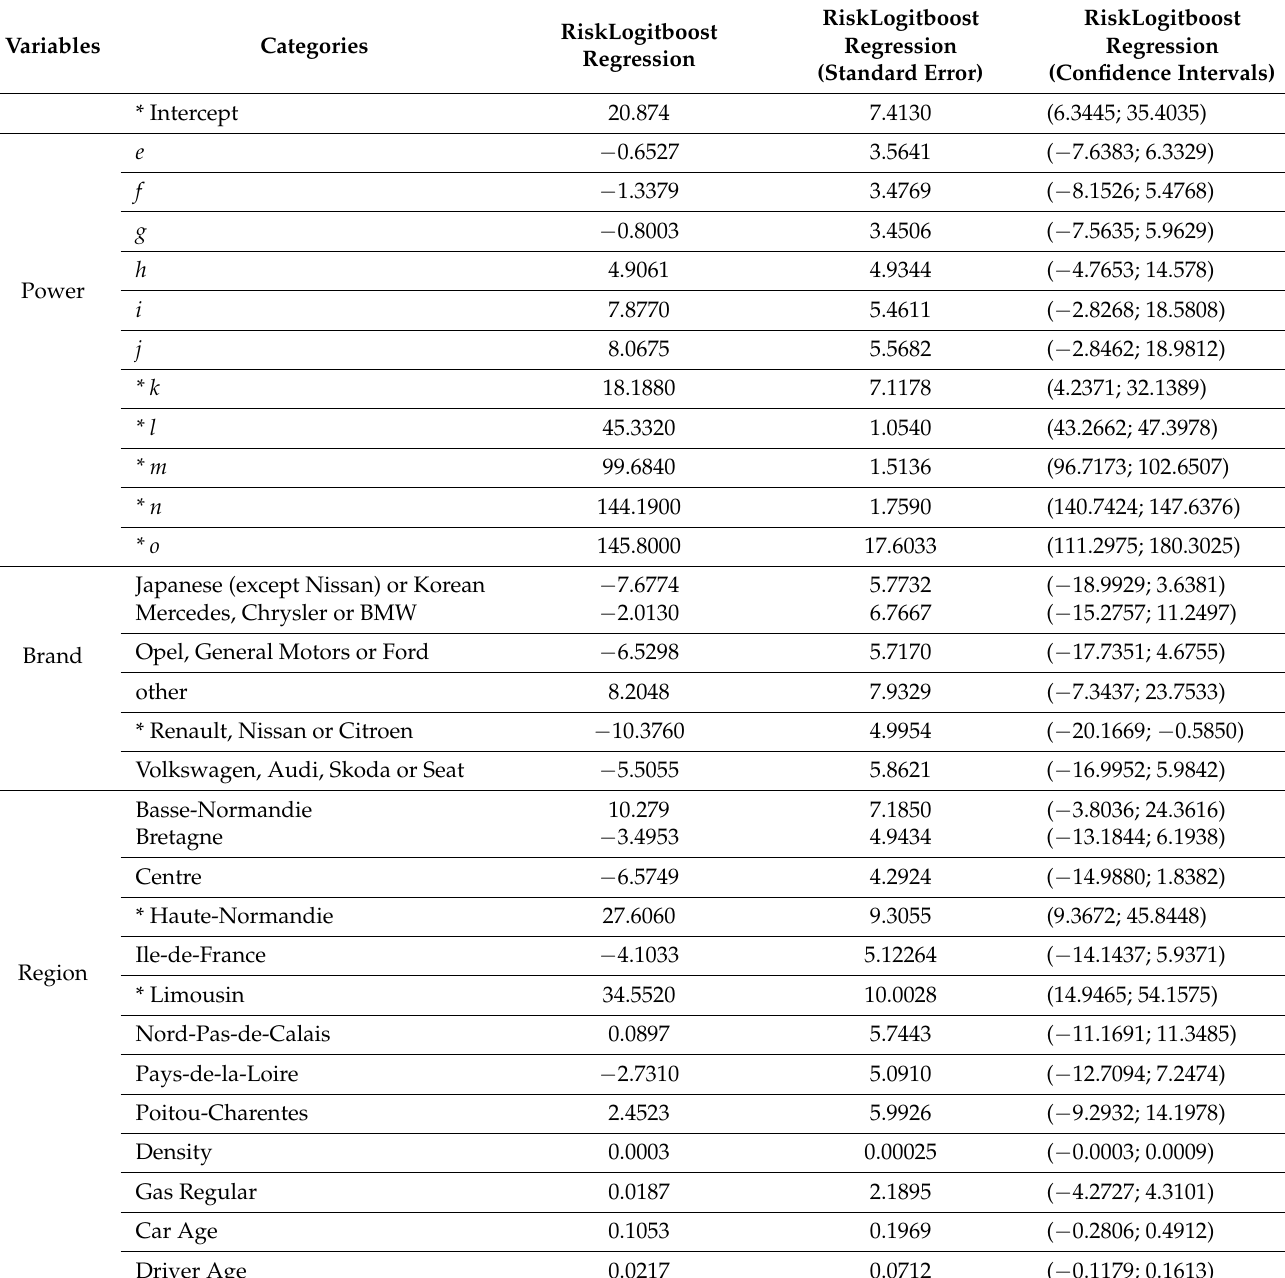
Table 3. Coefficient Estimates, Standard Error and Confidence Intervals provided by the RiskLogitboost